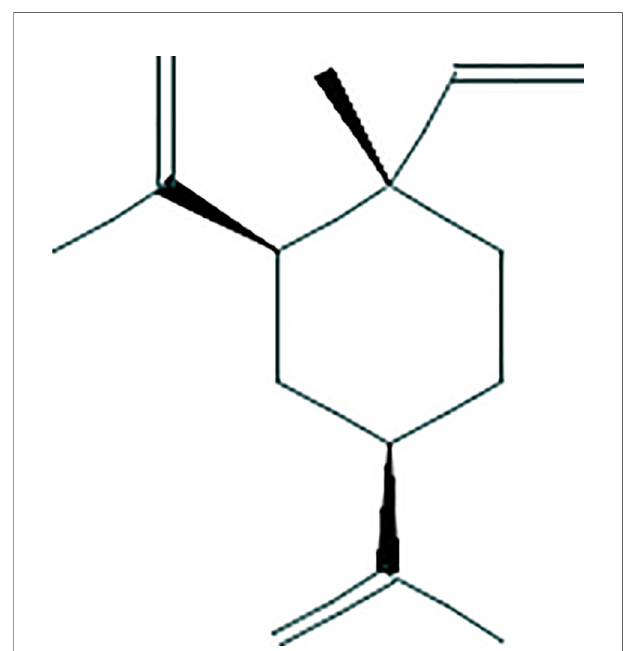
FIGURE 1 | The structure of